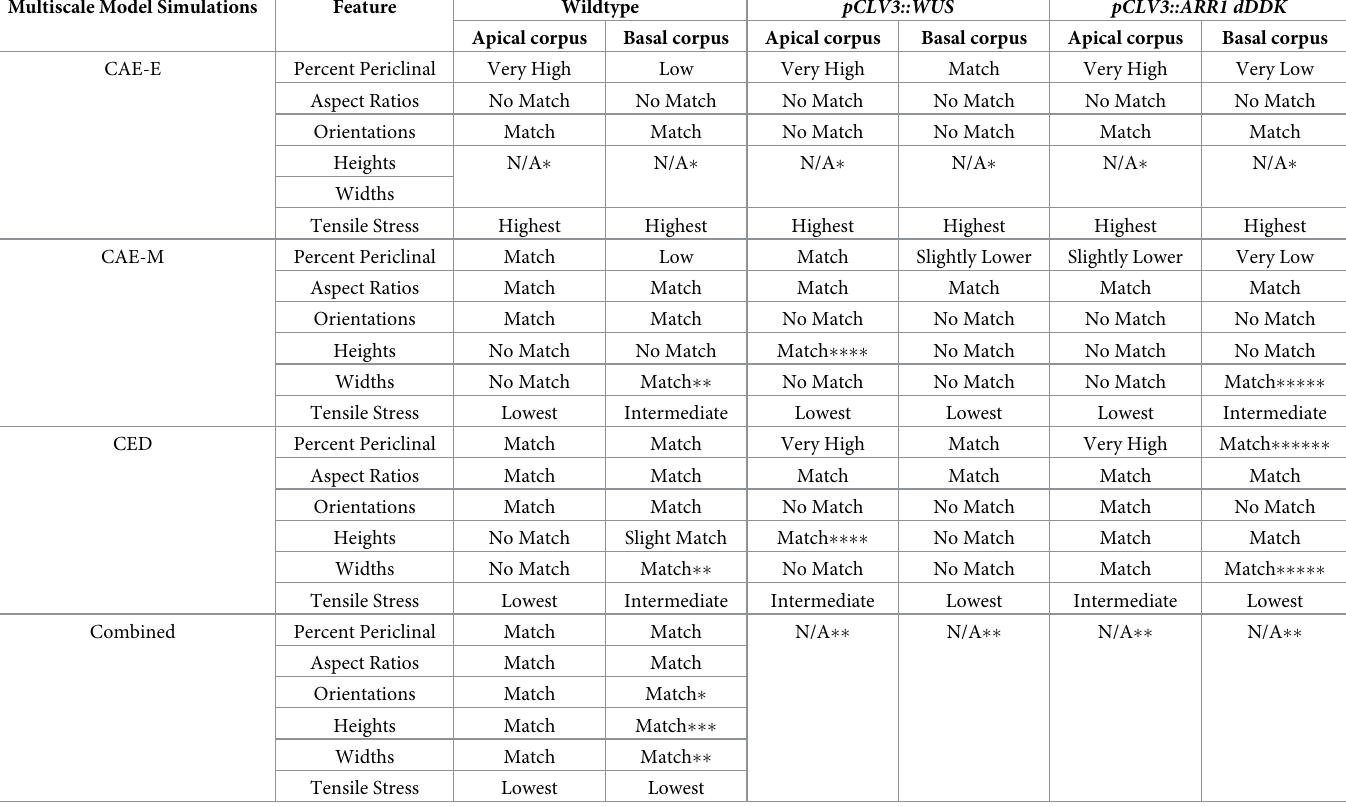
Table 1. Summary of cell-level features resulting from the testing of four hypothesized mechanisms of regulation compared to experiments. N/A � : Heights and widths were not computed for the CAE-E mechanism since it failed to reproduce the percent periclinal and aspect ratio observed in wildtype experiments. N/A �� : The combined mechanism was only simulated for wildtype conditions. � : Since we observed slightly more periclinal divisions in the Basal corpus for this mechanism compared to wildtype SAMs, this could explain why the distribution of mother cell orientations in this region does not directly match experiments. �� : While we found that the distri- butions of mother cell widths for all three mechanisms were significantly different from daughters (inconsistent with experiments), all three mechanisms exhibit similar behavior to experiments in that we see an increase in the number of mother mother cells whose widths are above the average. ��� : While we found that the distribution of mother cell heights was significantly different from daughters (inconsistent with experiments), the shape of the distributions for mother and daughter cell heights are simi- lar to experiments. The second peak of the mother cell distribution could be due to the slightly higher number of periclinal divisions in this region compared to experi- ments. ���� : While we found that the distributions of mother cell heights were significantly different from daughters (inconsistent with experiments), both mechanisms exhibit similar behavior to experiments in that we see an increase in the number of mother mother cells whose heights are above the average. ����� : While we found that the distributions of mother cell widths were significantly different from daughters (inconsistent with experiments), both mechanisms exhibit similar behavior to experi- ments in that we see an increase in the number of mother mother cells whose widths are above the average. ������ : While we observe significantly more periclinal divi- sions compared to experiments, the significant increase in periclinal divisions from the Apical corpus to the Basal corpus matched experimental